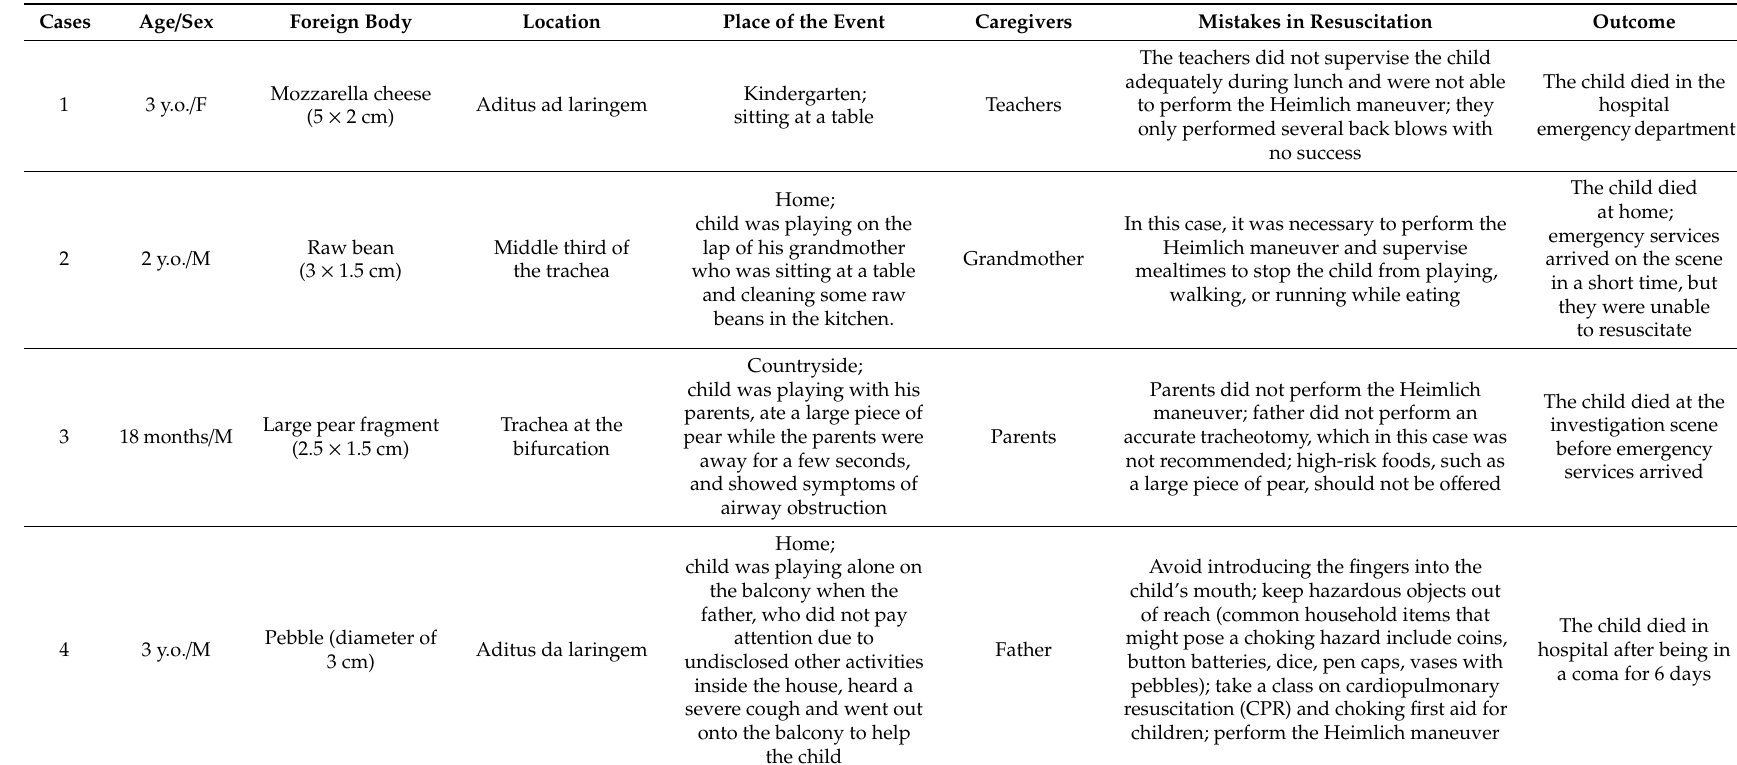
Table 1. Data regarding the